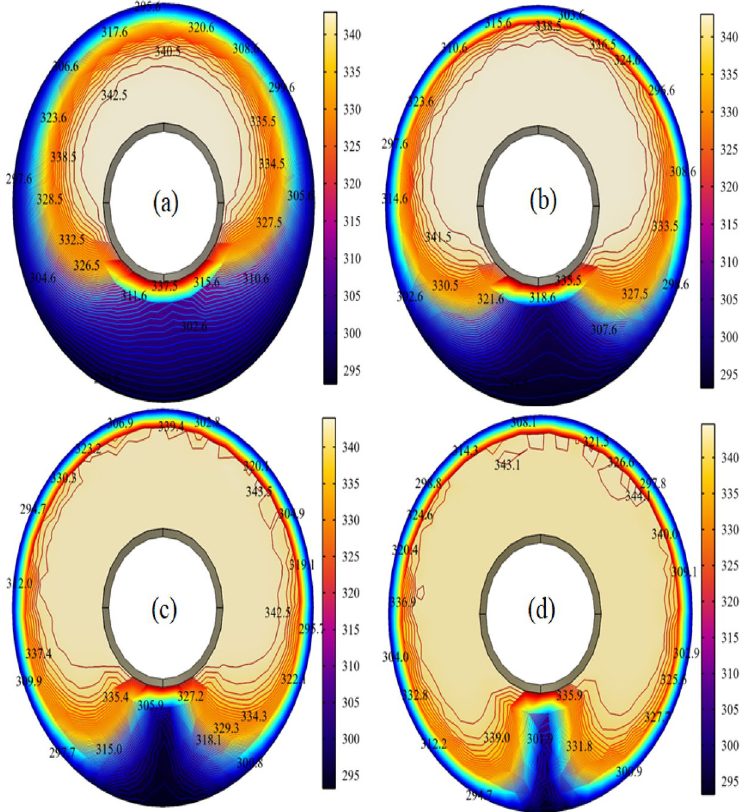
Figure 3. Surface and contour plots of the temperature when φ = 0.001 and Ar = 0.4 at ( a ) ω = 1 ( b ) ω = 2 ( c ) ω = 3 ( d ) ω = 4